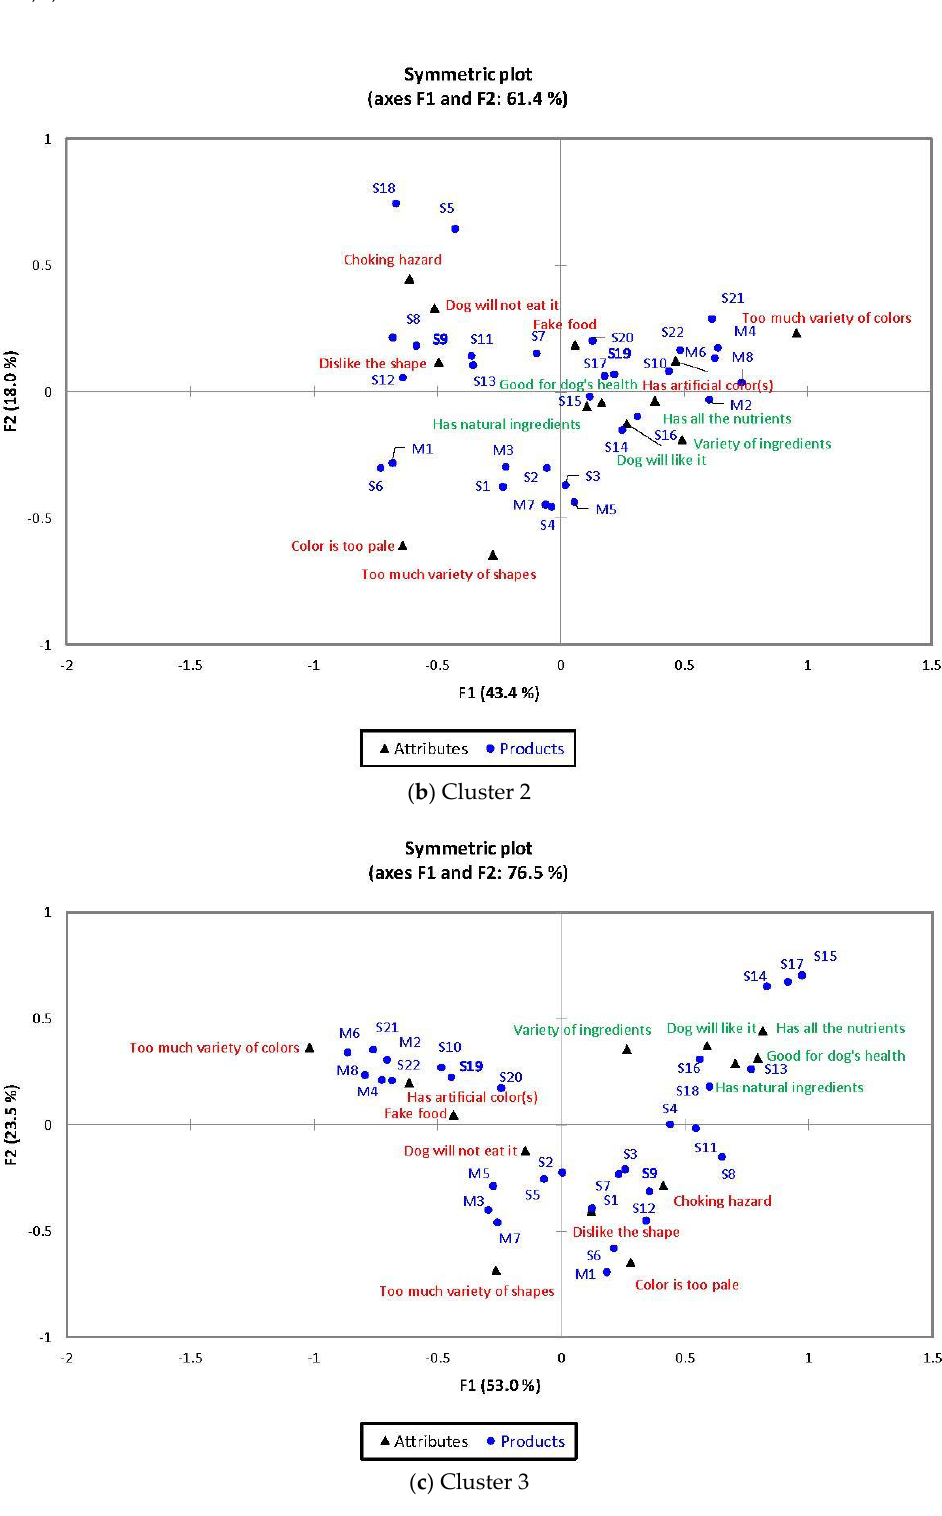
Figure 1. Correspondence Analysis maps between all thirty samples and all thirteen functional terms from the check-all-that-apply question. Positive terms shown in green; negative terms shown in red. Samples S5 (extra-large size) and S18 (extra-small size) were associated with the term “Consumption may cause choking hazard”. Samples S21, M2 and M4 contained red kibbles and were The terms “Has artificial color(s)” and “Looks like fake food” were associated with: (1) single-kibble samples of red (S21 and S22), green (S19 and S20) and amber brown (S10) colors; and (2) multiple-kibble samples with high-color-contrast containing red (M2, M4, M6, and M8) and green (M6 and M8) colors. As expected, high-color-contrast multiple-kibble samples (M2, M4, M6 and M8) were related